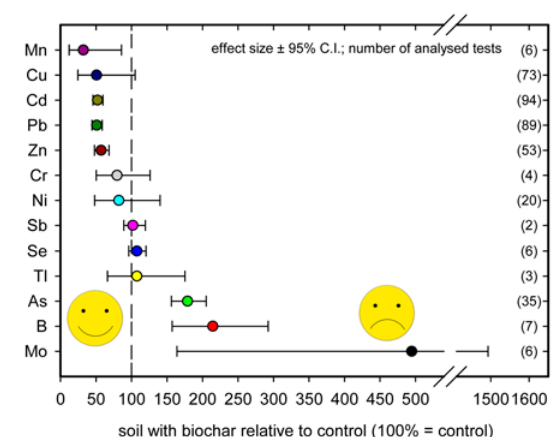
Fig. 3. Changes in the availability of elements from soil to soil solutions (studied with extractants simulating bioavailability for plant roots) in response to biochar additions in lab and field experiments. 100% means identical elemental availability in soils with and without biochar (= treatment and control). 50% means that in soils with biochar the elements were only half as available as in soils without biochar. 200% means that in soils with biochar the elements had double the availability compared to soil without biochar. The reduced availability (up to max. 100%) is a positive effect and therefore marked with a smiley. All studies that showed enhanced availabilities of heavy metals (>100%) after biochar amendments were marked with a frowny. Effect sizes (±95% confidence interval, C.I.) for different elements were calculated with MetaWin 2.1